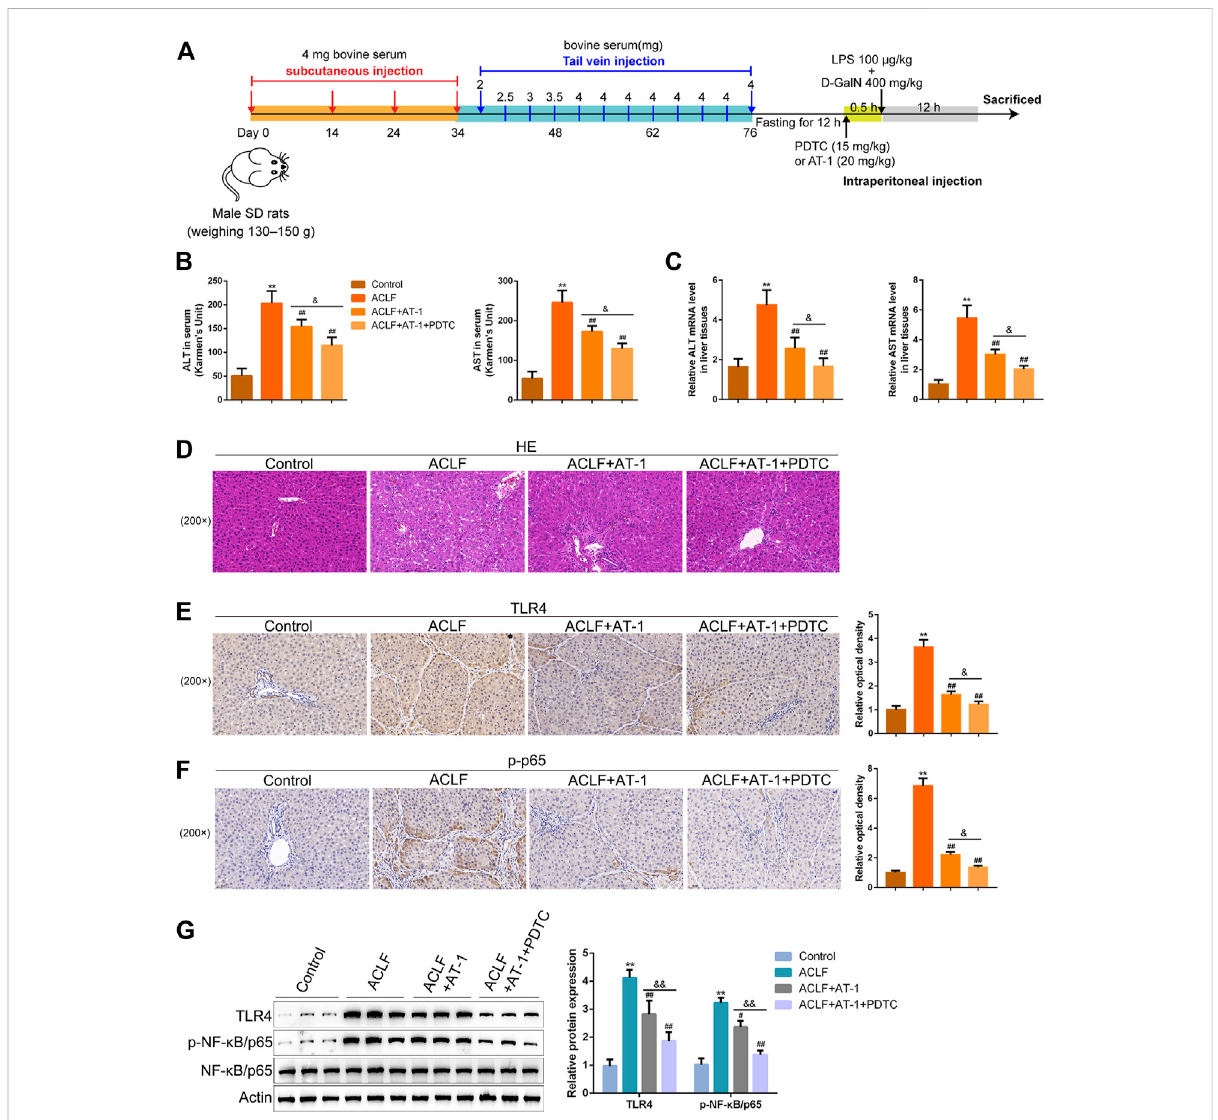
FIGURE 6 NF- κ B signaling is involved in AT-1 protection in the acute-on-chronic liver failure (ACLF) rat model. (A) Schematic diagram showing the procedures of the ACLF rat model and AT-1 or PDTC treatment. The rats were randomly allocated into control ( n = 6), ACLF model ( n = 6), ACLF model + AT-1 (n = 6), and ACLF model + AT-1 + PDTC ( n = 6) groups and treated accordingly. (B – C) Levels of ALT and AST were determined using ELISA in the serum or qRT-PCR assay in liver tissues. (D) Histopathological changes in liver tissues were evaluated by H&E staining. (E – F) Levels of TLR4 and p-p65 in liver tissues were evaluated by immunohistochemical staining (IHC). (G) Levels of TLR4, p-p65, and p65 in liver tissues were evaluated by immunoblotting. N = 6; ** p < 0.01 compared to the control group; ## p < 0.01 compared to the ACLF model group; & p < 0.05 and && p < 0.01 compared to ACLF+AT-1